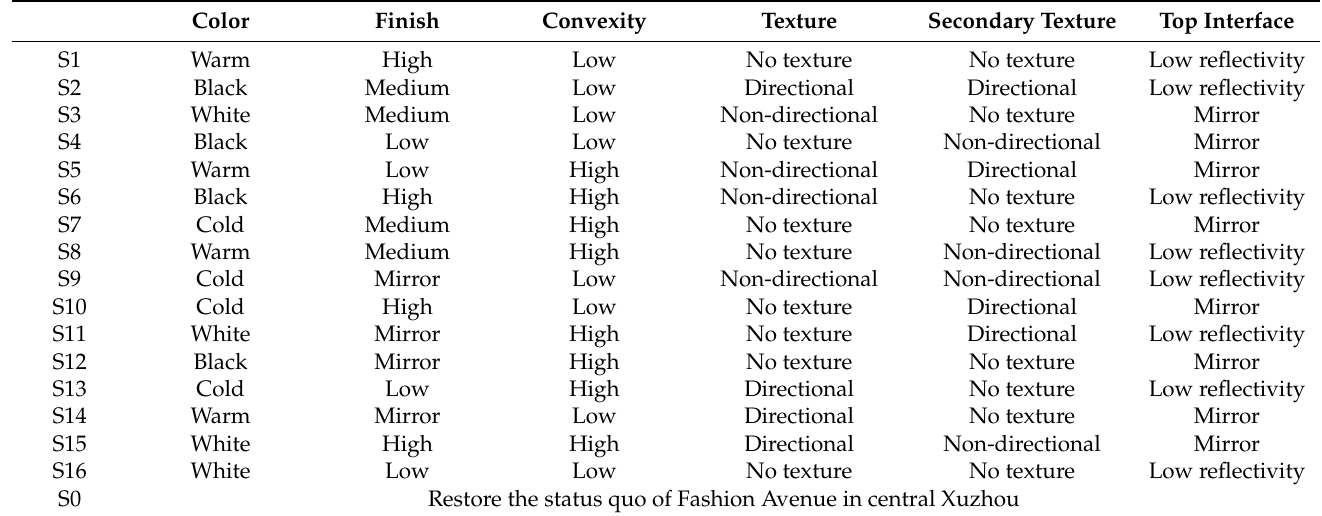
Table 4. Orthogonal design results of independent variables in experimental scenes.